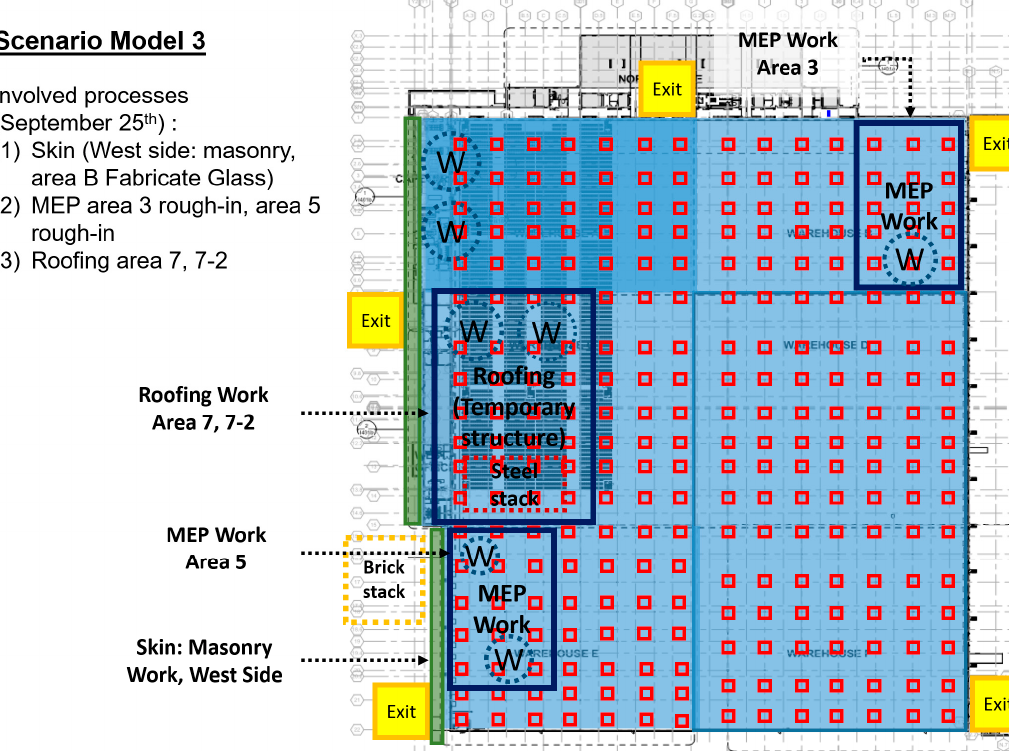
Figure 9. Scenario Model 4: Work status and site conditions.